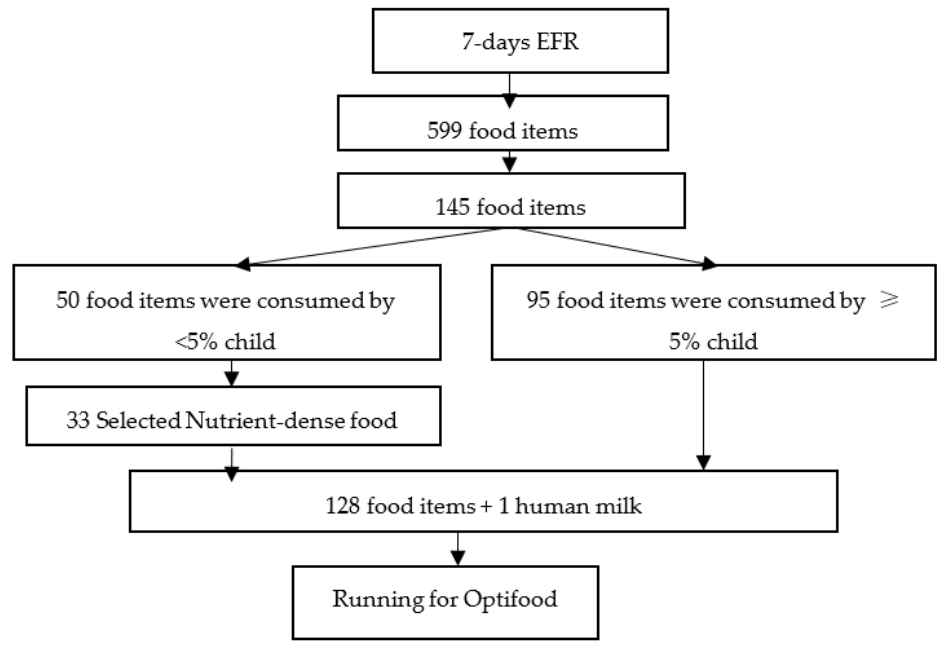
Figure 1. Number of Food Item Consume by Children and for Running the Optifood.